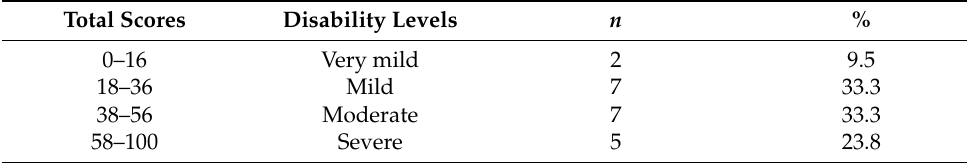
Table 3. Disability levels of THI scores in the tinnitus